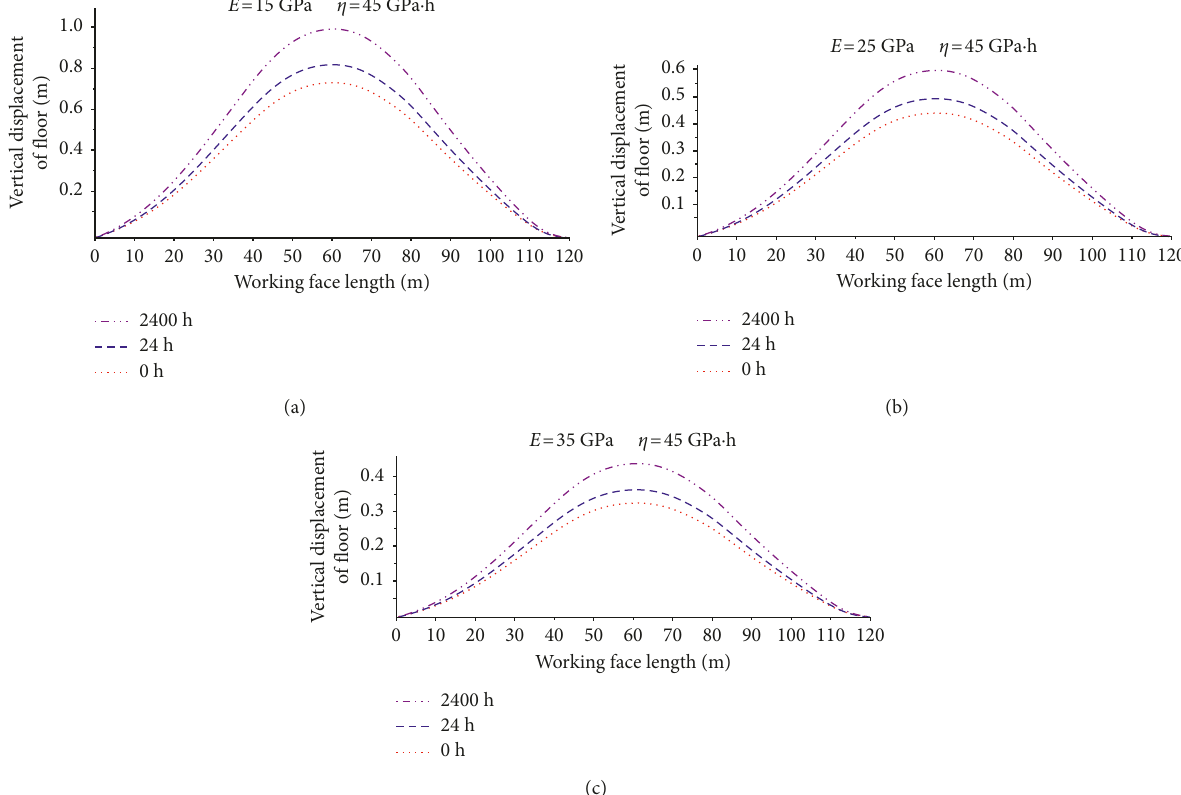
15GPa. (b) E 25GPa. (c) E (cid:29) (cid:29) (cid:29)